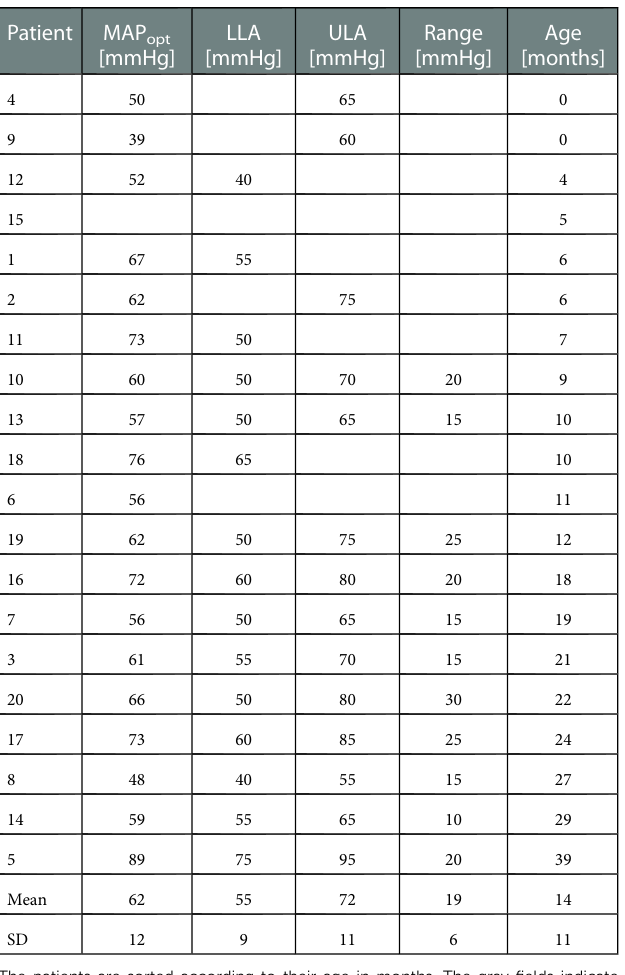
TABLE 2 Identi fi ed characteristics of cerebral blood fl ow autoregulation in each patient.